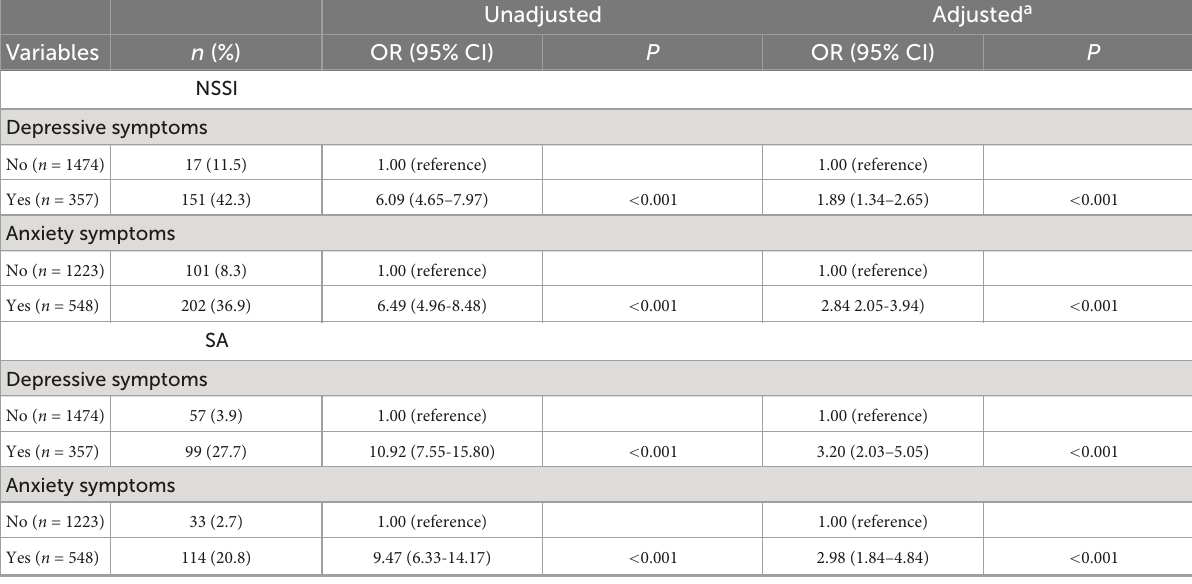
TABLE 2 Frequencies, prevalence, and odds ratio of depressive and anxiety symptoms by NSSI or SA.